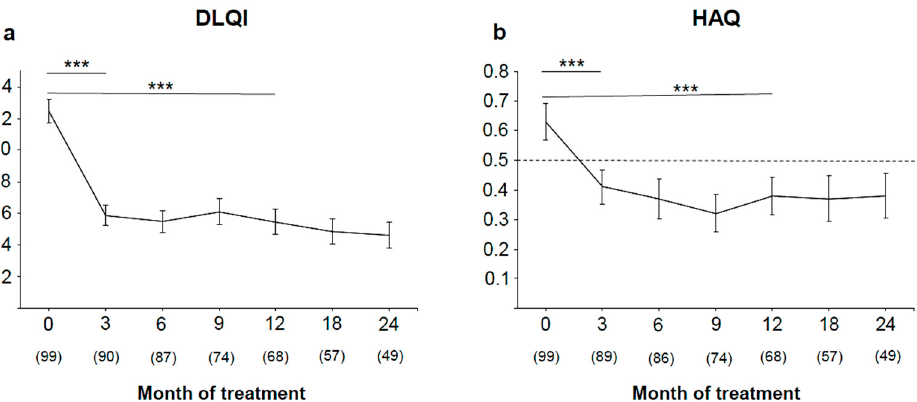
Figure 4. Reduction of ( a ) Dermatological Life Quality Index (DLQI) and ( b ) Health Assessment Questionnaire (HAQ) during therapy. Absolute values of DLQI and HAQ scoring (mean ± SEM) and total number of patients per visit are shown; dashed line represents HAQ 0.5 as functional target for disease control. *** p <